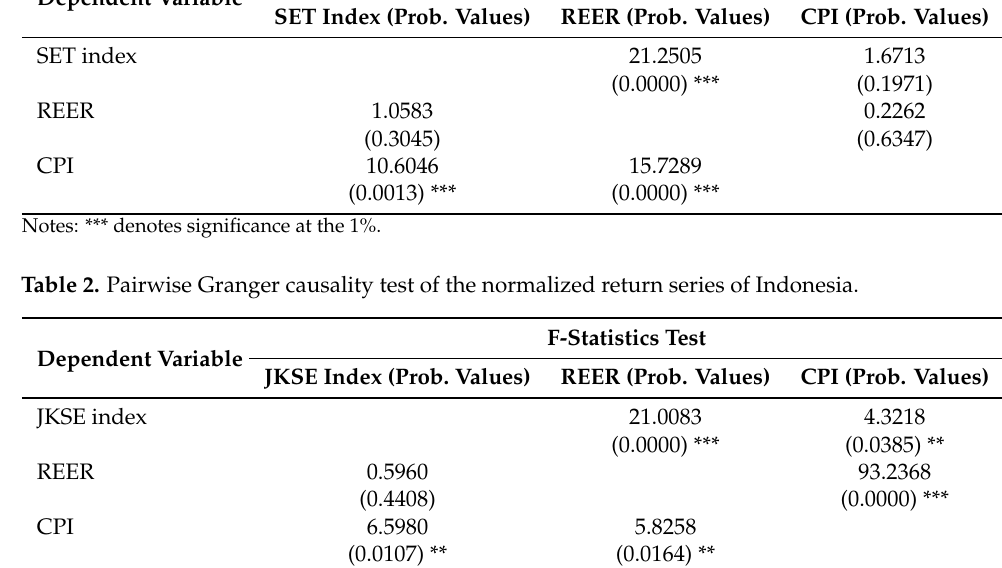
Table 1. Pairwise Granger causality test of the normalized return series of Thailand. Dependent Variable